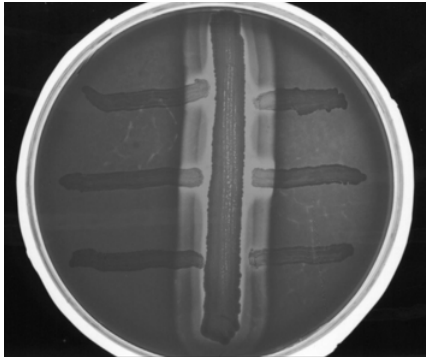
Figure 1. Synergistic hemolysis between a beta-hemolytic S. aureus strain (vertical) and six S. epidermidis strains. The first two strains on the left and right showed an increase in S. aureus beta hemolysis, while the last two yielded a negative result.